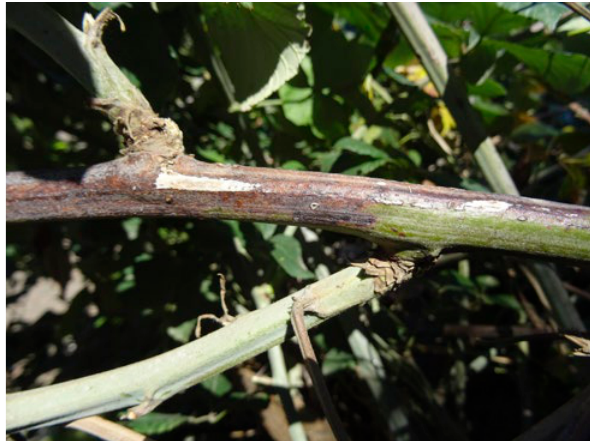
Figure 1. Stem canker, caused by Neofusicoccum parvum , on a thornless blackberry plant grown in southern Italy.